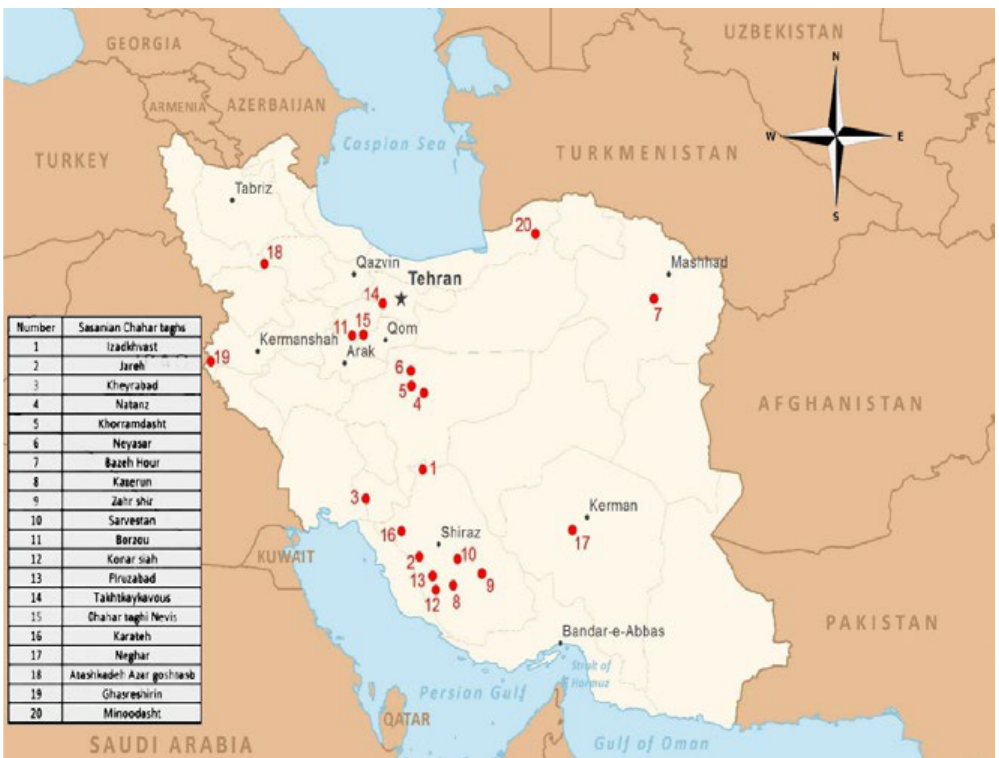
Fig. 2: Geographical locations of the square domes studied in Iran- Scale: 1/10000000 Fig. 2. Geographical locations of the square domes studied in Iran- Scale: